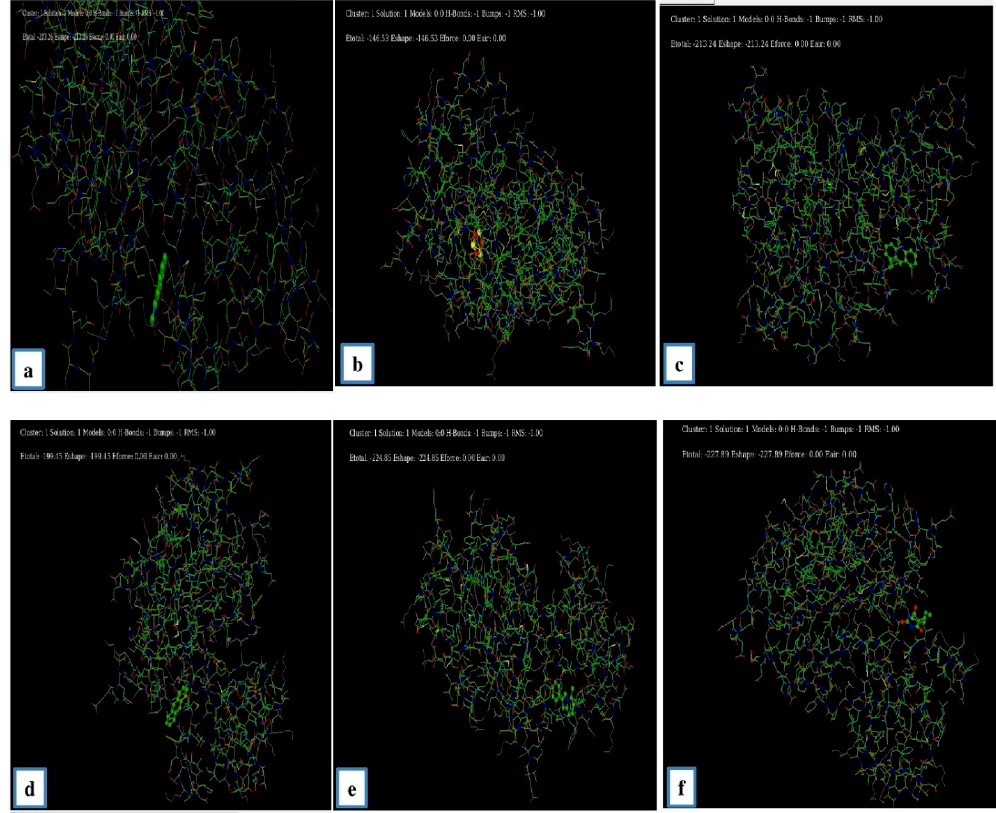
Figure 6. The interaction of bioactive metabolites of endophytic fungi (ligands) and the EGFR receptor. EGFR interaction with ( a ) Benzo (h) Quinoline, ( b ) Cyclotrisiloxane, ( c ) Ethylacridine, ( d ) Anthracene, and ( e ) 5-methyl 2 phenylindolizine and ( f ). Brallobarbitol. Table 10. E-value scoring pattern of EGFR Receptor and endophytic fungal metabolites (Ligands) obtained through molecular docking study.